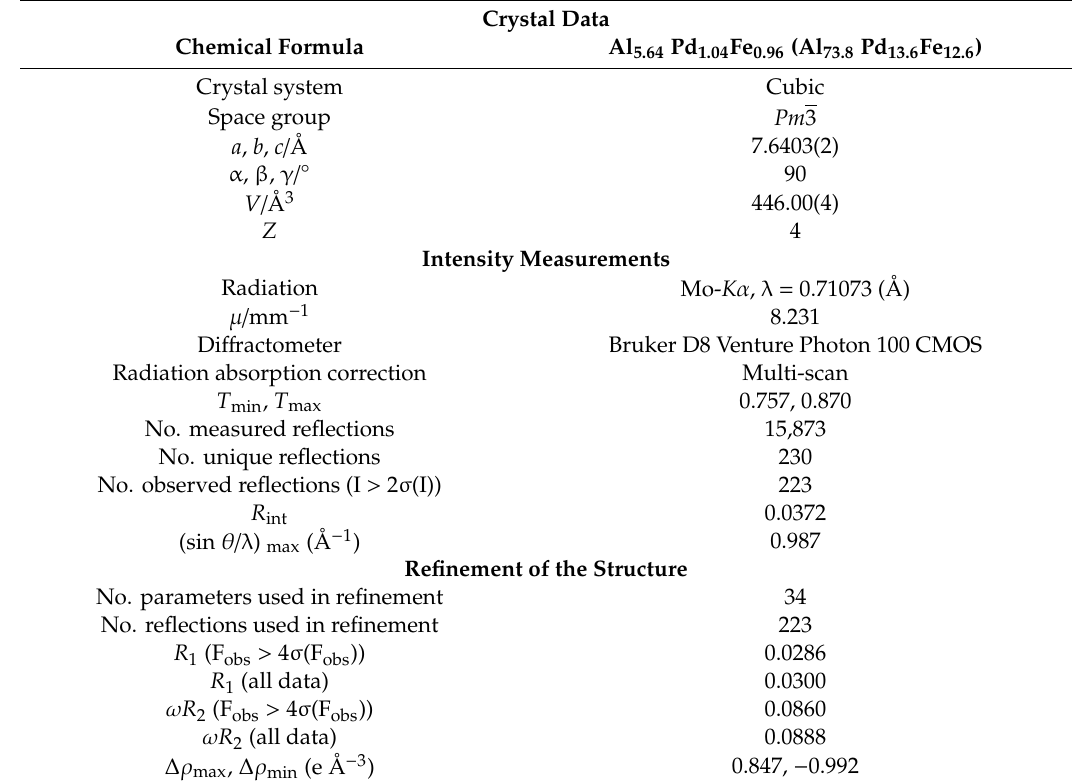
Table 2. The crystallographic data of the C (cid:48) -phase.